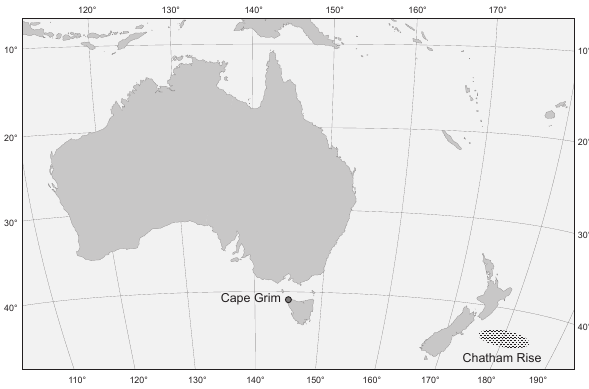
Figure 1. Cape Grim and Chatham Rise sampling